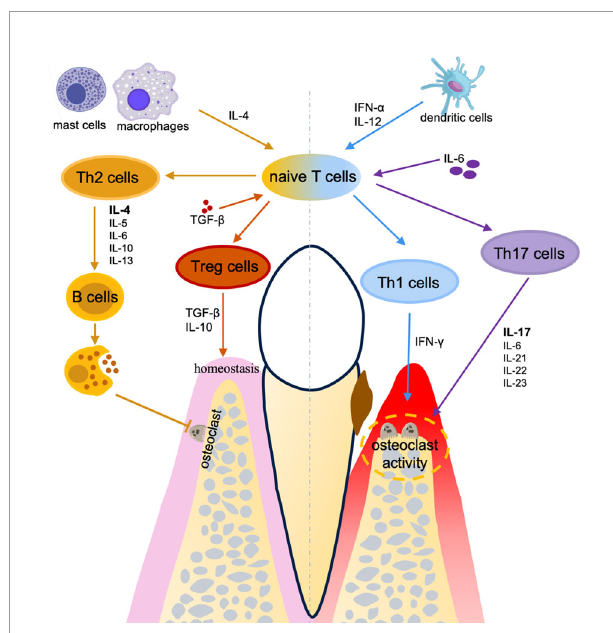
FIGURE 2 | The effects of CD4 + T cells in periodontal diseases. A homeostasis of T helper subsets between pro-in fl ammation (Th1/Th17) and anti-in fl ammation (Th2/Treg) plays a critical role in the pathogenesis and therapies for periodontal